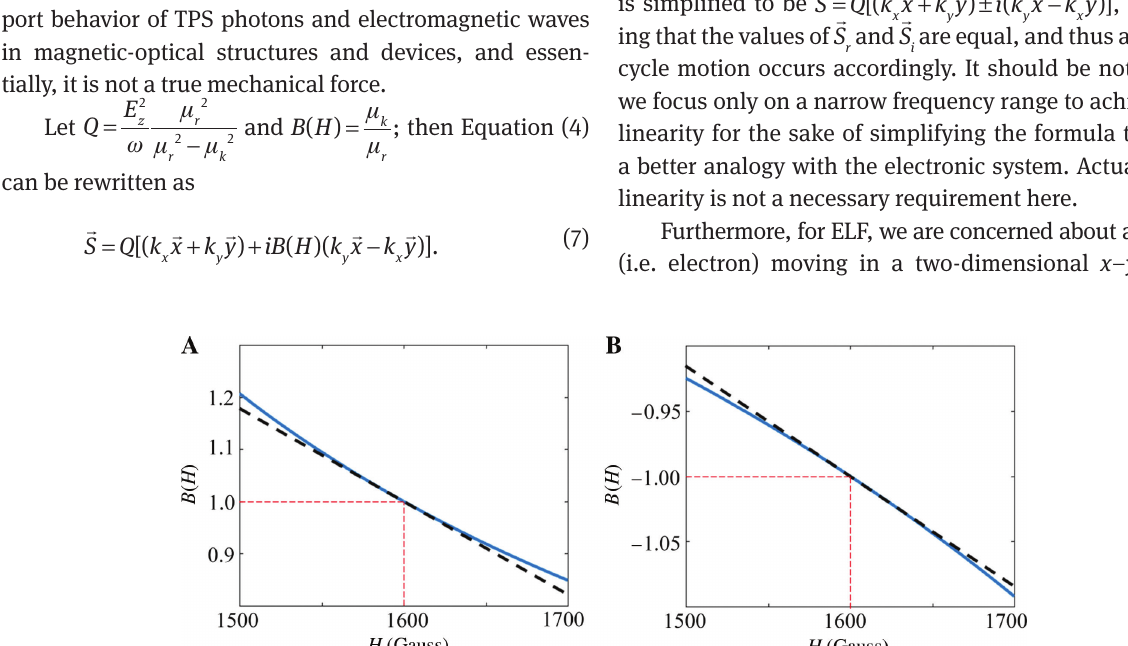
= 4.480 GHz, (B) f = 9.464 GHz. The black dotted lines are the reference 1 2